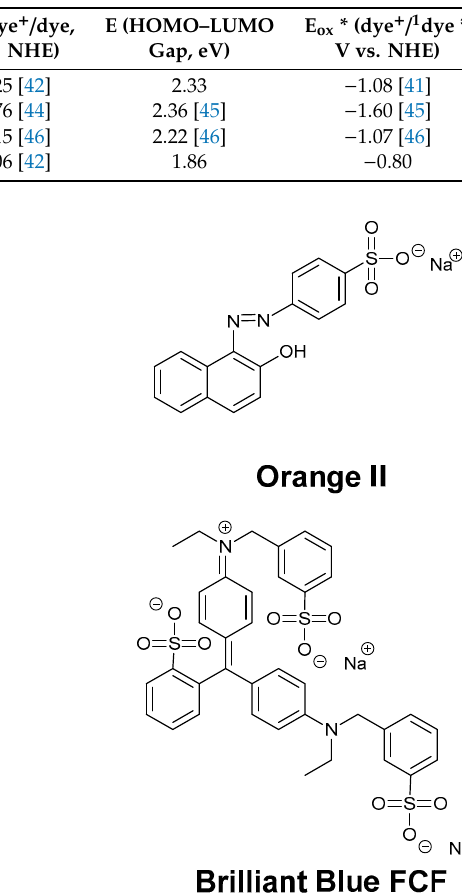
Table 1. Photophysical properties and electrochemical data of the selected synthetic dyes [40]. NHE: normal hydrogen electrode.